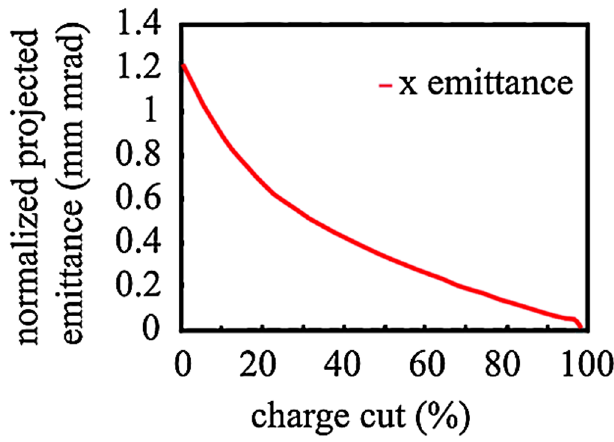
FIG. 38. (Color) Normalized projected rms emittance as a func- tion of the charge cut fraction starting from the lowest density regions in the phase